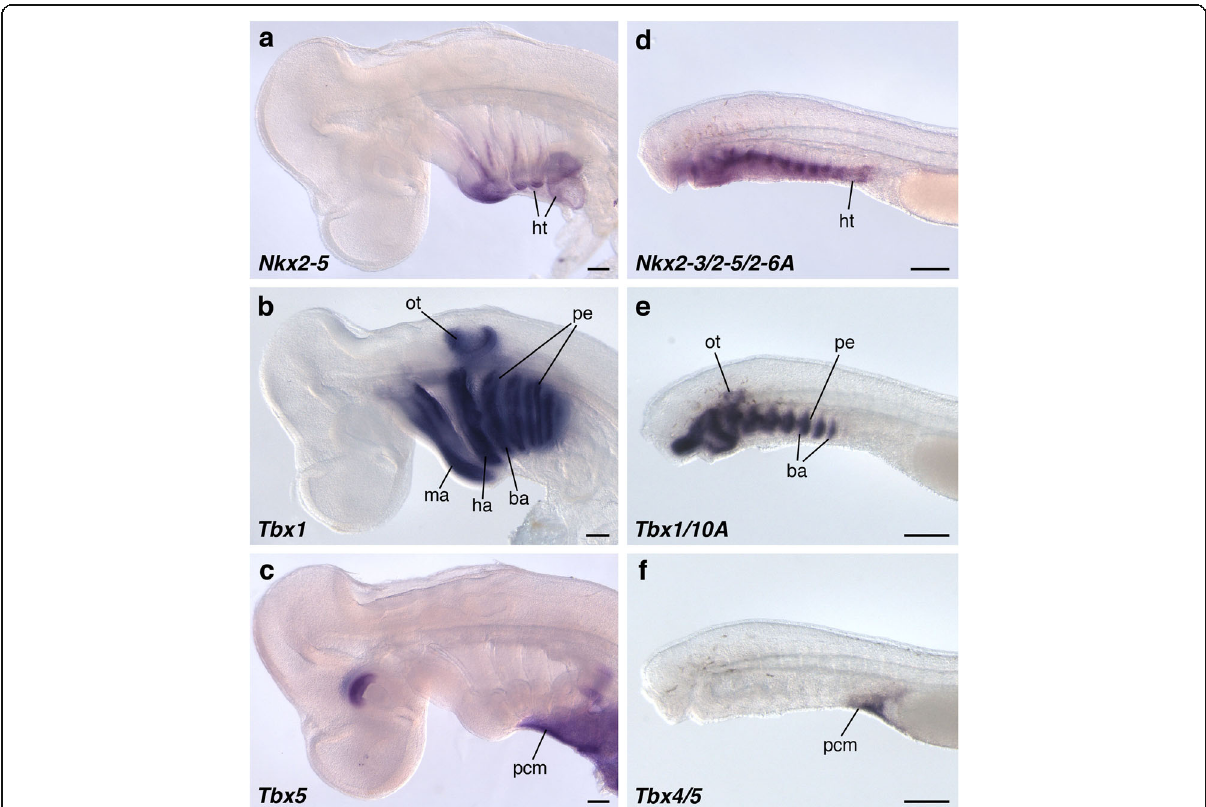
Fig. 5 The relative position of the pericardium and pharyngeal arches. Nkx2 – 5 ( a ), Tbx1 ( b ), and Tbx5 ( c ) expressions in S . torazame at the stage 25 from the lateral view. Nkx2 – 3/2 – 5/2-6A ( d ), Tbx1/10A ( e ), and Tbx4/5 ( f ) expressions in the lamprey at the stage 26 from the lateral view. Nkx2 – 5 and Tbx5 homologs were expressed in the cardiac mesoderm. Tbx1 cognate genes were detected in the pharyngeal arch mesoderm and endoderm. Note that the cardiac mesoderm resided ventral to pharyngeal arches in shark embryos, whereas the cardiac mesoderm lay posterior to the arches in lamprey embryos. ba, branchial arch mesoderm; ha, hyoid arch mesoderm; ht., heart tube; ma, mandibular arch mesoderm; ot, otic vesicle; pcm, pericardial mesoderm; pe, pharyngeal endoderm. Scale bars, 200 μ